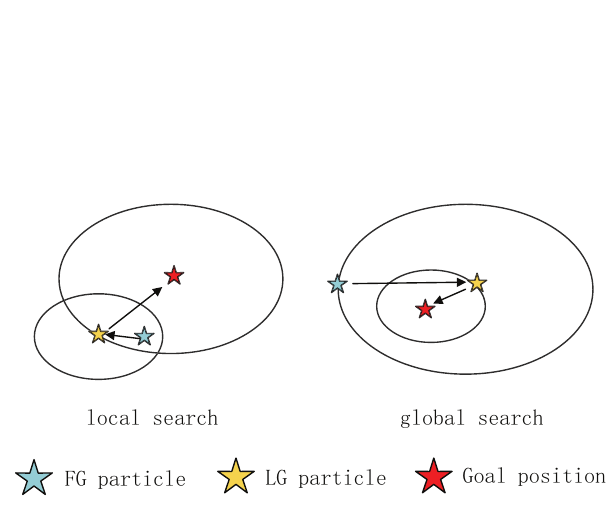
Figure 1: Possible situations of pair-wise